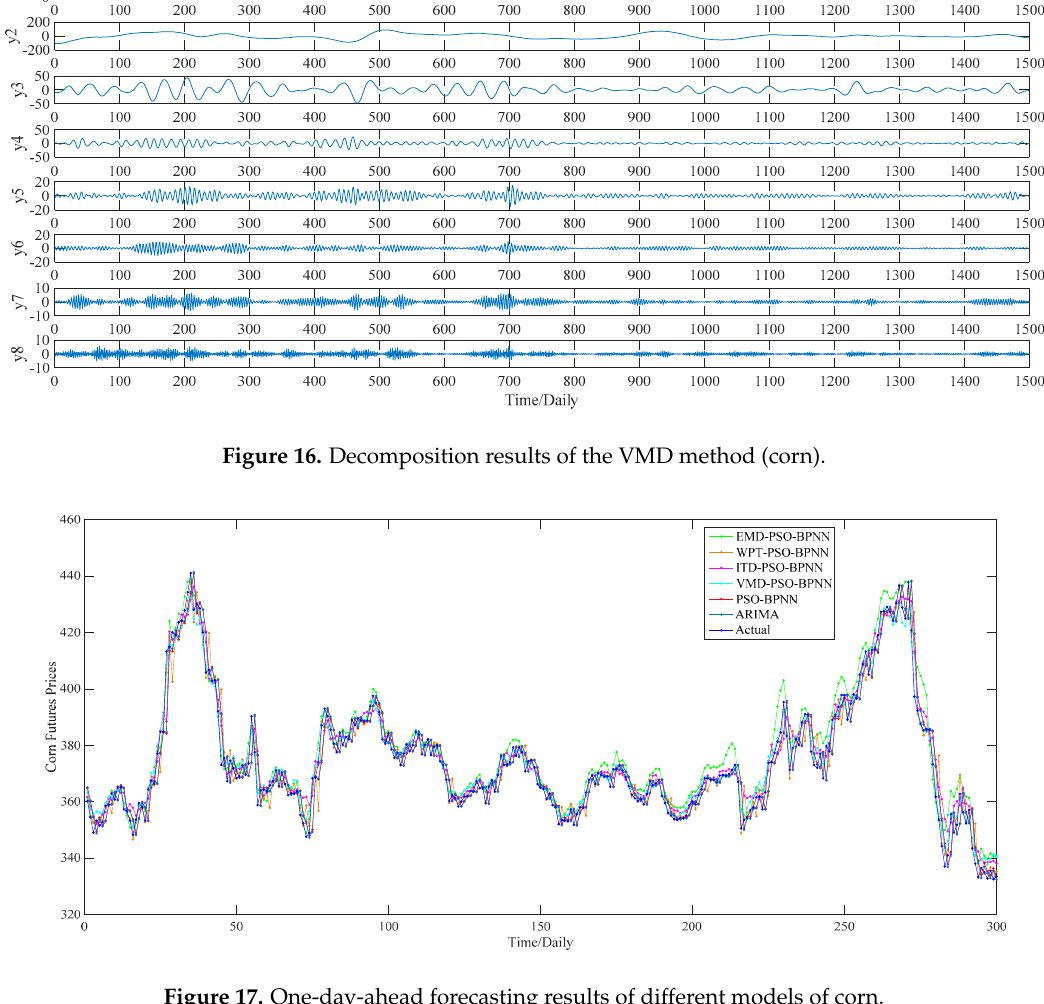
Figure 17. One-day-ahead forecasting results of different models of corn. Algorithms 2017 , 10 , 108